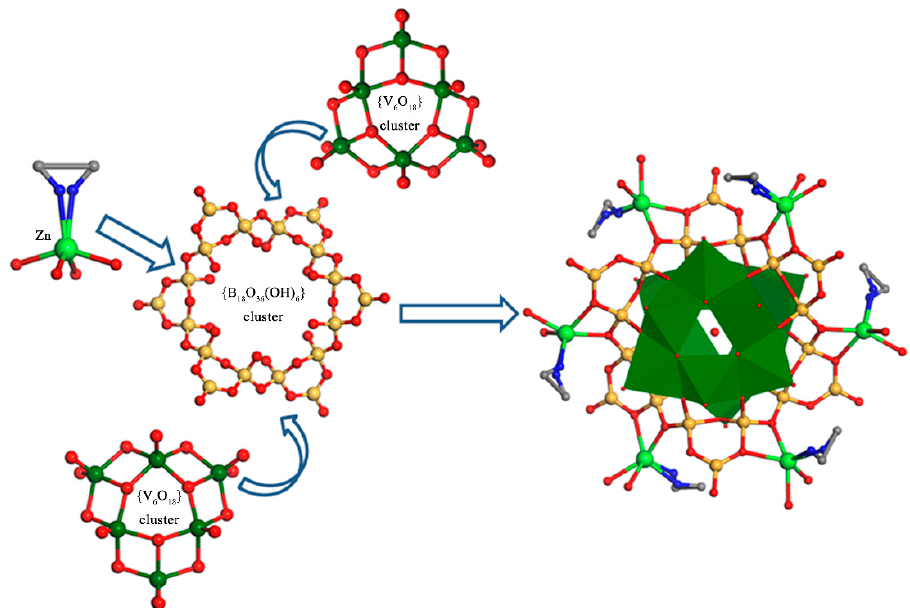
Figure 3. An illustration of the formation of the molecular structural unit of compound 1 . Color code: O, red; V, dark green; B, yellow; Zn, green.